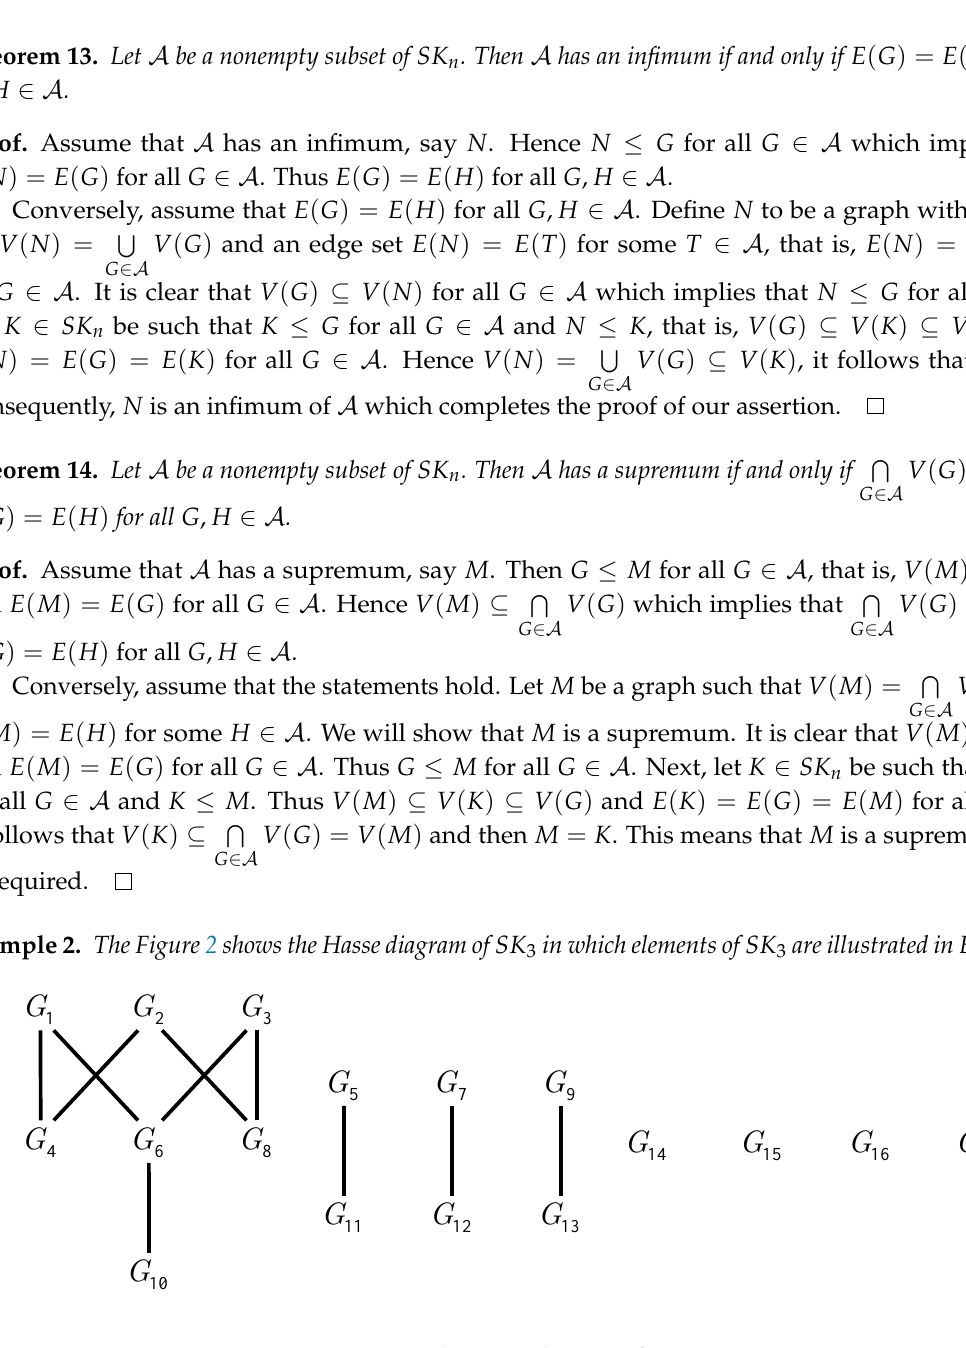
Figure 2. The Hasse diagram of SK 3